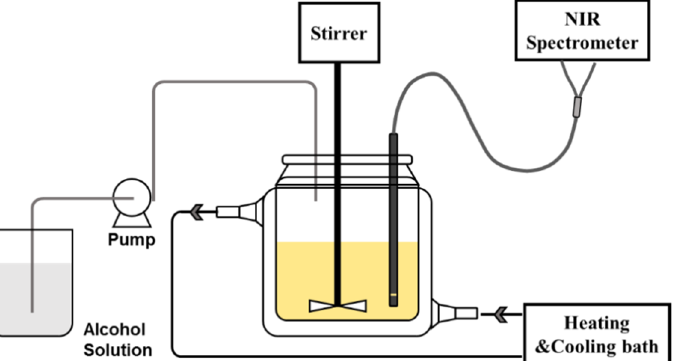
Figure 1. Schematic of the experimental setup for the second alcohol precipitation process.